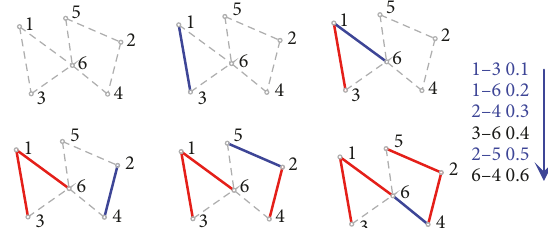
Figure 12: The extraction of a minimum spanning tree from a six vertices network using Kruskal’s MST Algorithm. We rank all edges in descending order according to the edge lengths. Starting from the shortest edge and add the edges into the tree but avoiding loops or circles, after considering all edges, we get a final tree connecting all vertices with the minimum total edge lengths. In our example, after adding 𝑒 1,3 , 𝑒 1,6 , 𝑒 2,4 , 𝑒 2,5 , and 𝑒 6,4 , we finally extract a tree of 𝑇 3,1,6,4,2,5 with a total length of